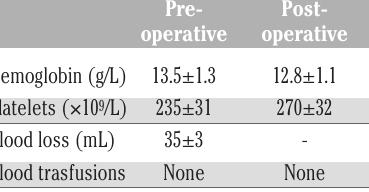
Table 4. Hematologic